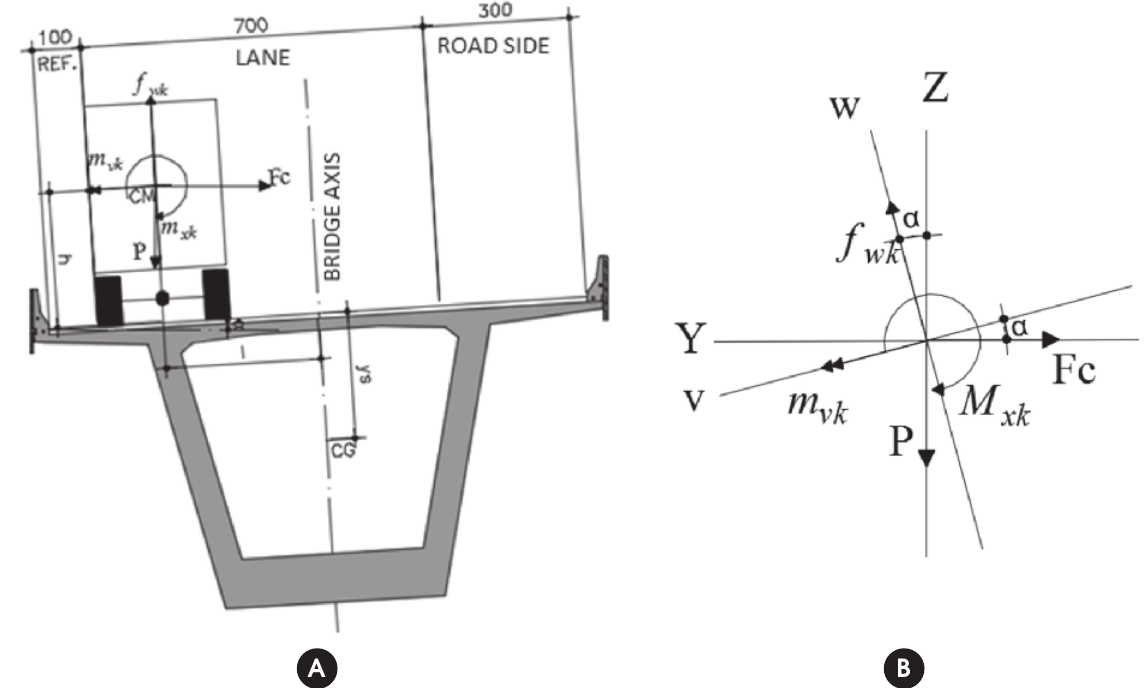
B (a) Positioning of the vehicle to calculate the forces. (b) Decomposition of the forces, according to super elevation